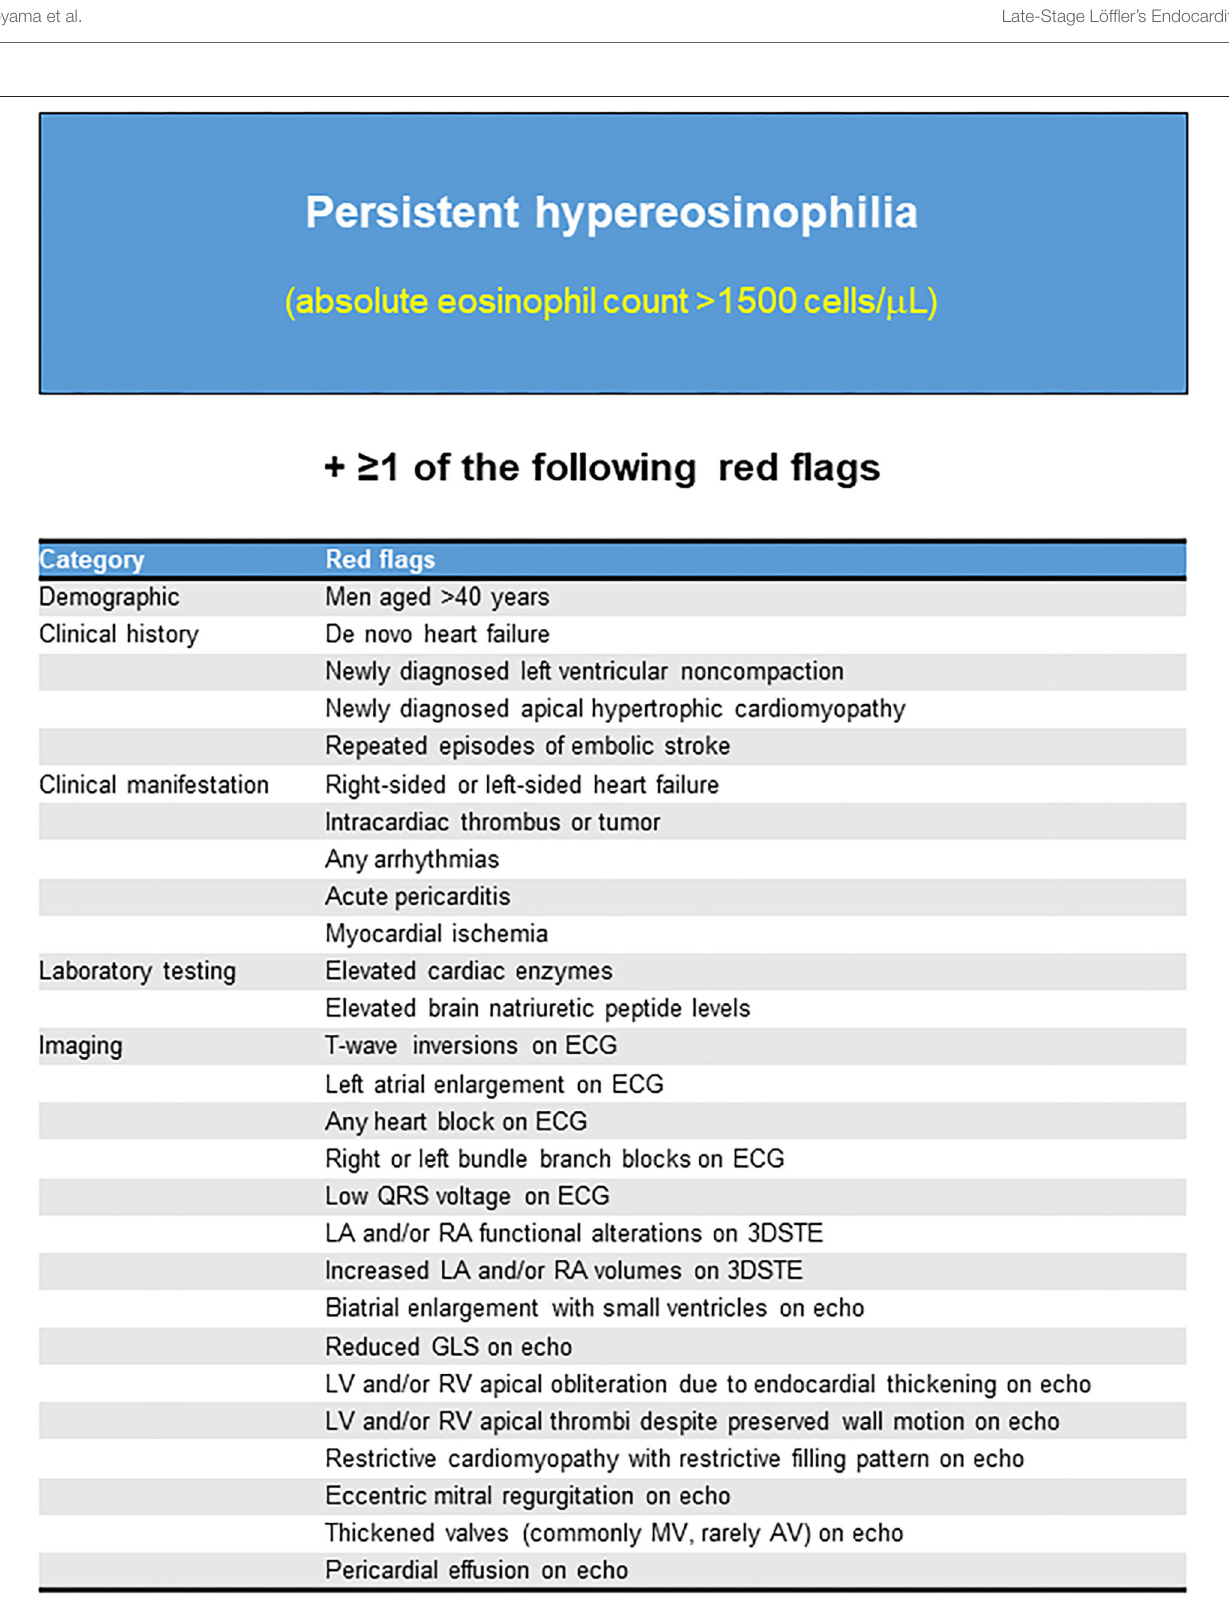
Frontiers in Cardiovascular Medicine |